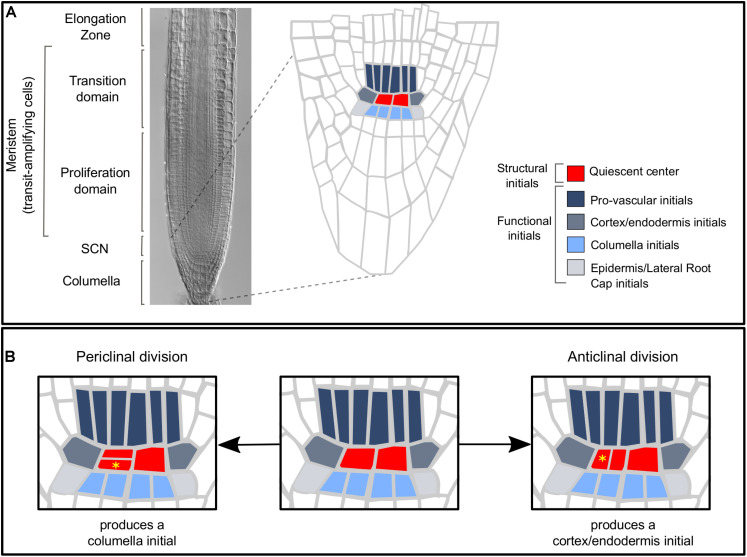
(A) The root apical meristem is composed of the SCN, the proliferation domain, and the transition domain (Ivanov and Dubrovsky, 2013). The SCN houses the QC cells and the ICs [structural and funcional initials, respectively (Barlow, 1997)] which divide asymmetrically and produce cells of different root tissues. The QC cells produce most root tissues and are considered a reserve of multipotent stem cells. (B) QC divisions can be periclinal or anticlinal and produce columella initials or cortex/endodermis initials, respectively. Yellow asterisks mark the daughter cells that replace an initial cell in each case.